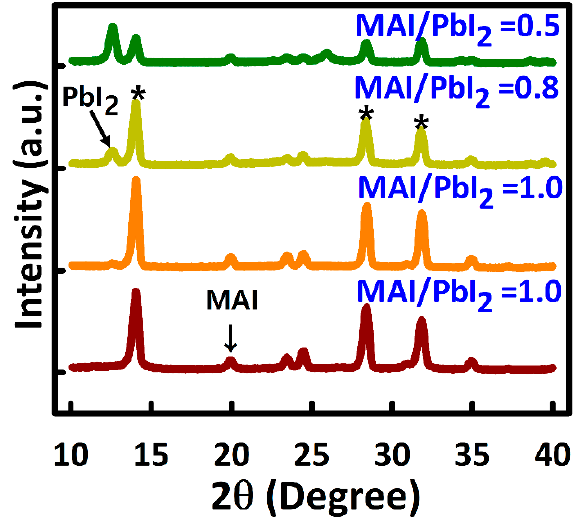
Figure 3. X-ray diffraction (XRD) patterns of MAPbI 3 films of varying MAI/PbI 2 ratio.